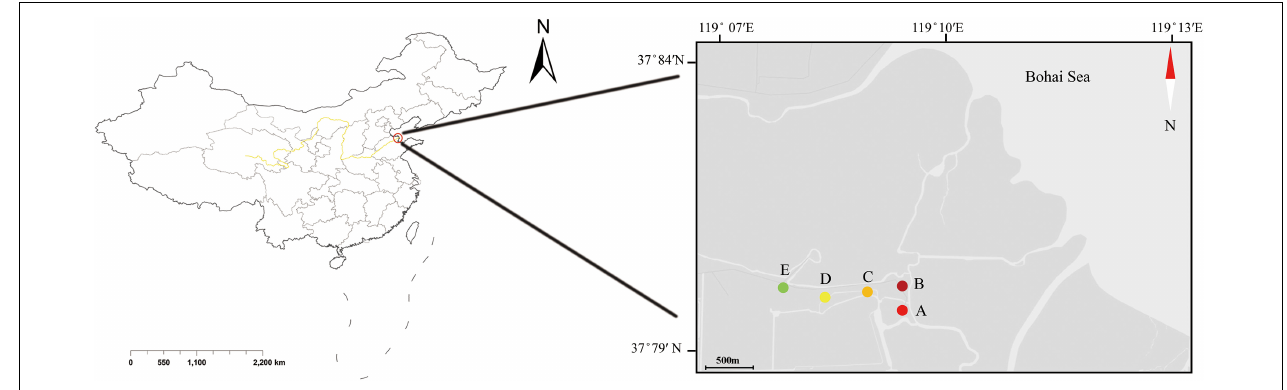
FIGURE 1 | The geographical location of the sampling sites. A total of five sites were set up around the Yellow River Delta. The Yellow River flows in Shandong Province, China, and the red circle represents the study area (version ArcGIS 10.2).